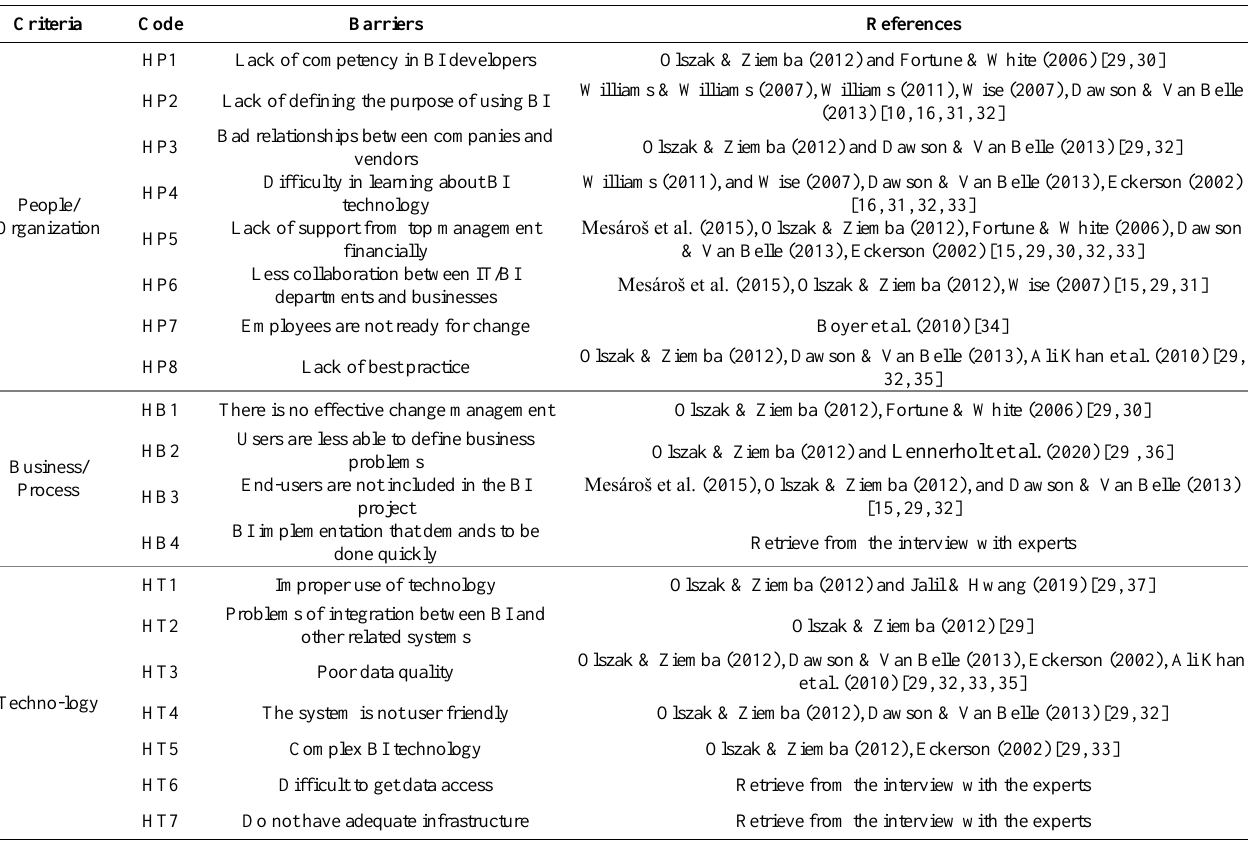
Table 1. List of Obstacles in BI Project Development